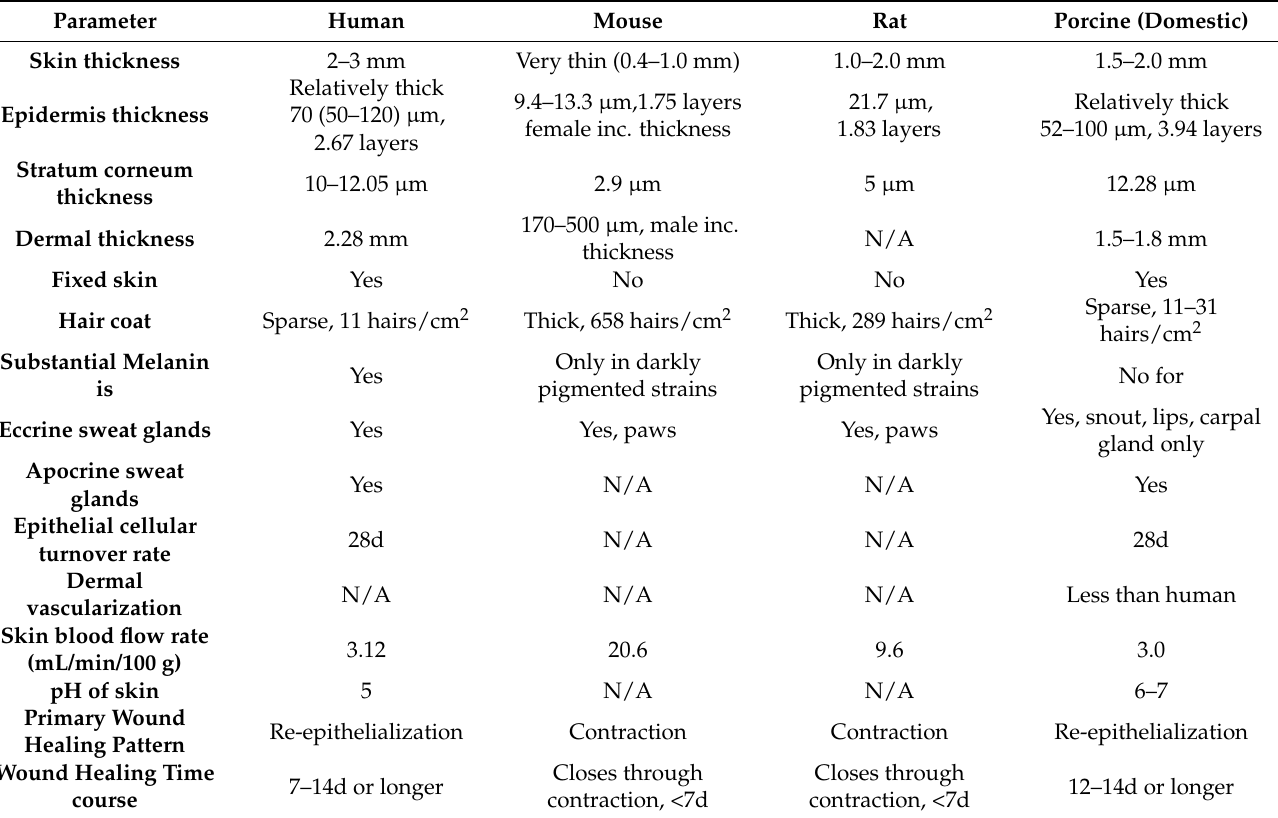
Table 1. Skin characteristics of different species according to wound healing models (modified from [5]). Parameter Human